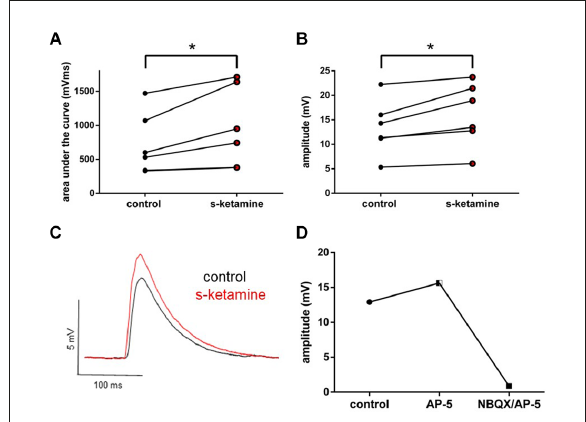
FIGURE4 s-ketamine led to a significant (*) increase of the AUC ( p = 0.031) (A) and the amplitude ( p = 0.031) (B) of thalamocortical oEPSPs (mixed AMPA-/NMDA-receptor mediated). Cohen’s U3_1 was 1 (1 1) for the AUC and the amplitude. (C) Representative traces. (D) Adding NMDA-receptor antagonist AP-5 and AMPA-receptor antagonist NBQX led to a vanishing of thalamocortical oEPSPs (mixed AMPA-/NMDA-receptor mediated).